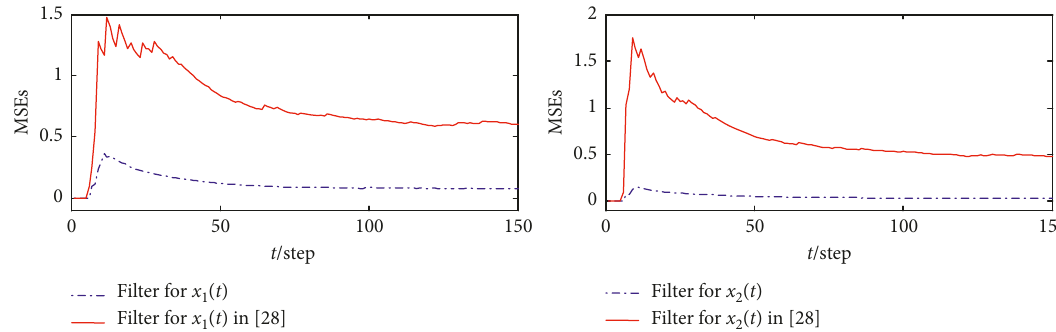
Figure 3: Comparison between the MSE curves of the filter and that of the predictor in [28].